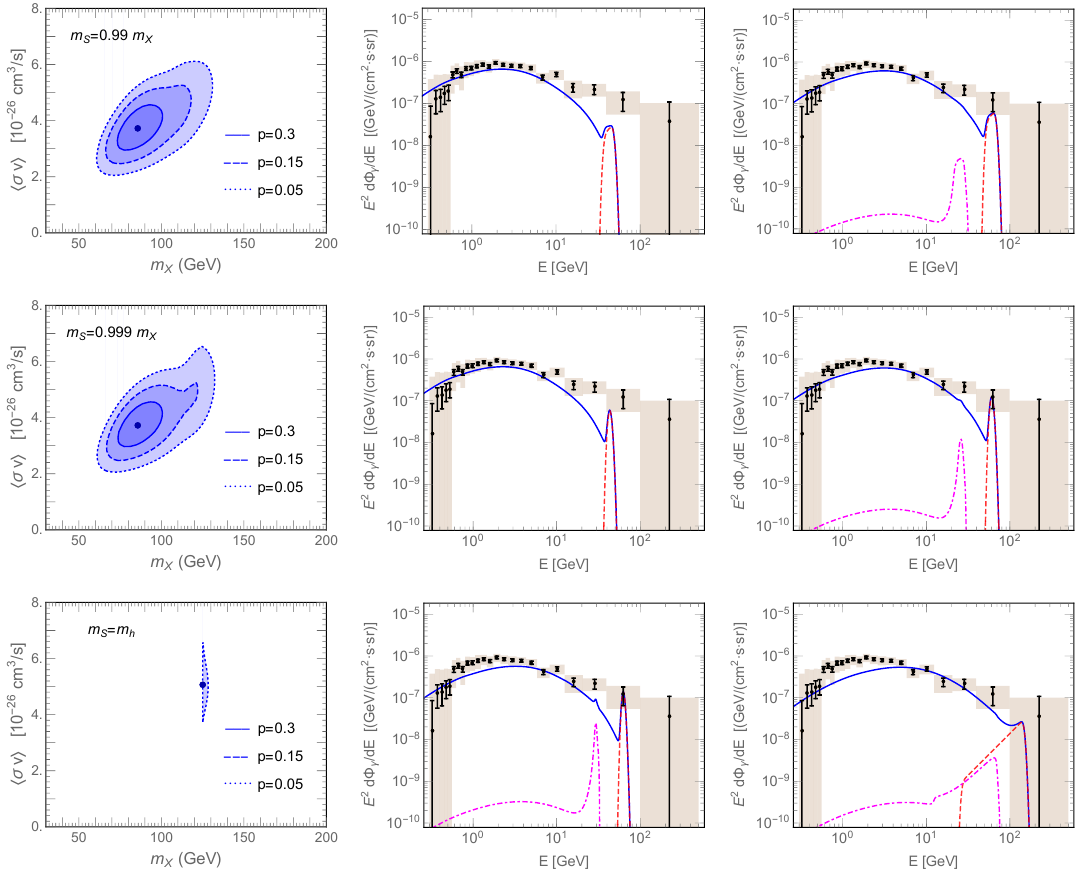
Figure 4 . Panels from up to down are, respectively, the results using m S = 0 : 99 m X ; 0 : 999 m X and m h (= 125 : 18 GeV) as the input. All analyses refer to (cid:26) (cid:12) = 0.4 GeV/cm 3 and (cid:13) = 1 : 2 in the gNFW pro(cid:12)le, and the detector energy resolution (cid:24) = 0 : 1. Left panel: GC excess data preferred regions, where the corresponding p -values of boundaries are given, and the best-(cid:12)t point is denoted as the black dot. Middle panel: the best (cid:12)t (blue curve, using the best (cid:12)t values of m X and h (cid:27)v i as inputs) vs. GC excess spectrum [25] for which the error bars represent the statistical errors, while brown rectangles represent the diagonal part of the covariance matrix from systematical errors, including empirical model systematics and residual systematics. The corresponding spectra resulting from S ! (cid:13)(cid:13) and Z(cid:13) are depicted by the dashed (red) and dot-dashed (magenta) curves. Right panel: same as the middle panel but the values for m X and h (cid:27)v i are rescaled by 1.4 times to draw all the corresponding curves; this is for illustrative purposes. See table 1 for the best-(cid:12)t values (for the middle panel) and the corresponding p -values, while for the right panel from up to down the theoretical curves correspond to p = 0 : 12, 0 : 15, and 2 (cid:2) 10 (cid:0) 6 . (see (cid:12)gures 2 and 4). As shown in (cid:12)gure 4, the observed spectral line width is very